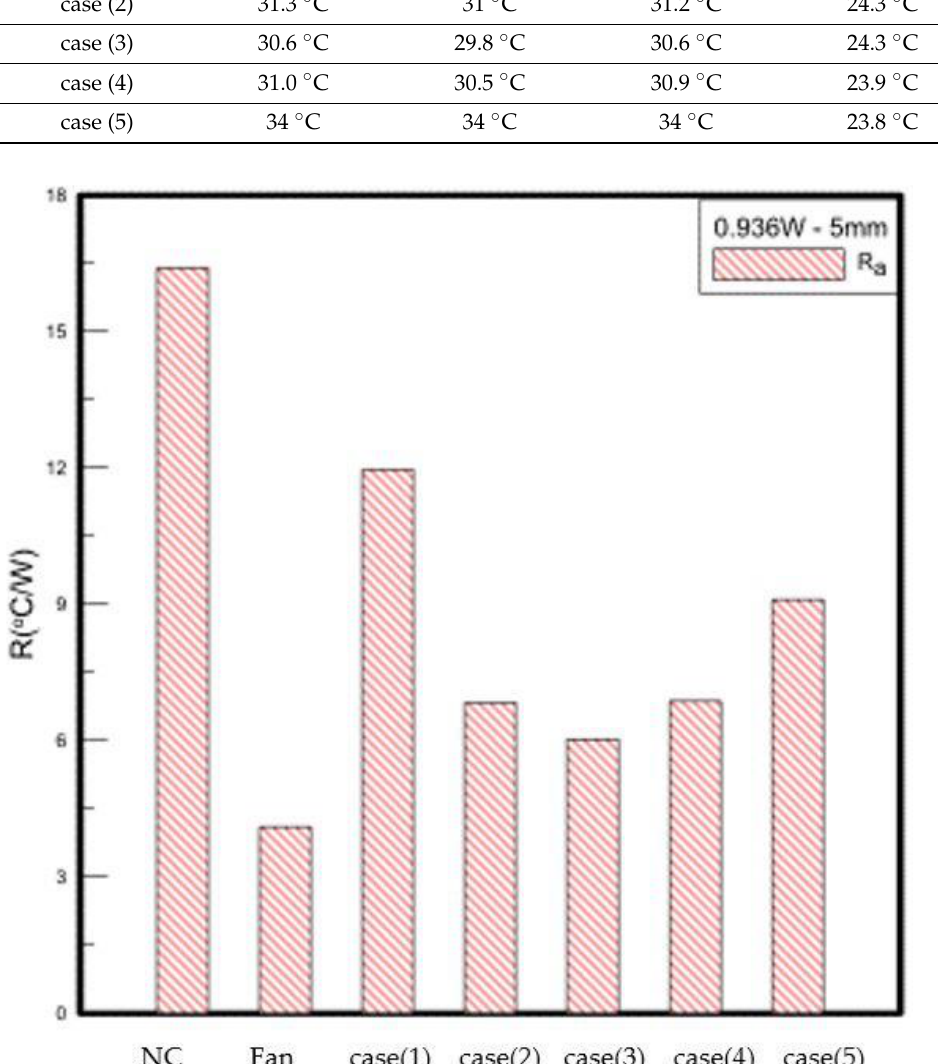
Figure 13. 1 W LED experimental data.